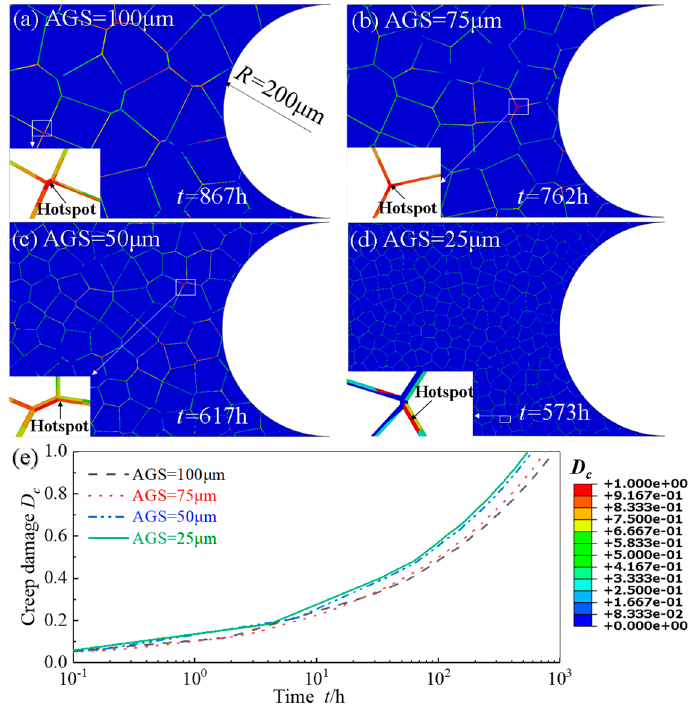
Figure 10. Distribution of creep damage of notch specimens with different AGSs: ( a ) 100 μ m; ( b ) 75 μ m; ( c ) 50 μ m; ( d ) 25 μ m and ( e ) the evolution curves of D c of hotsopts from ( a – d ).